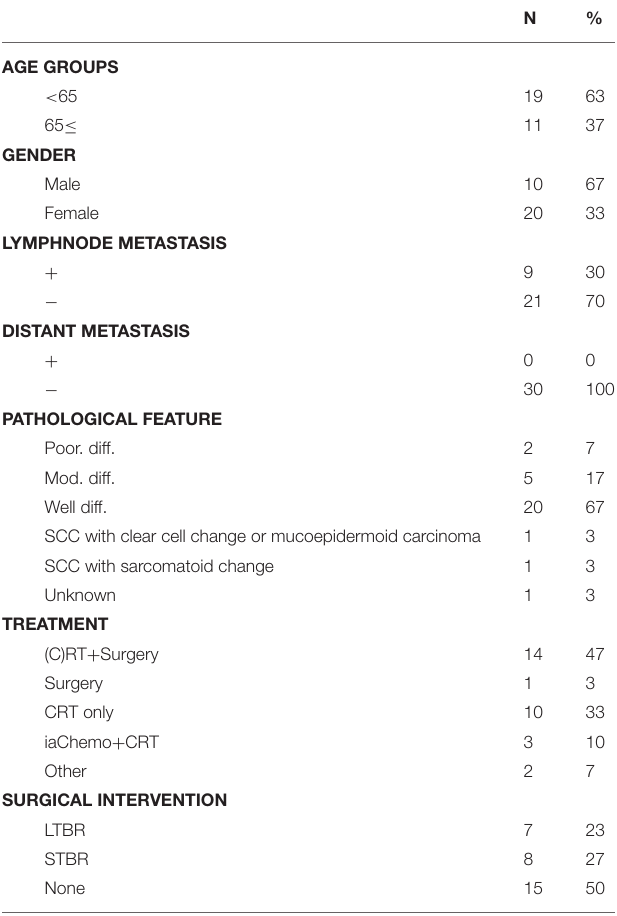
TABLE 2 | Patient